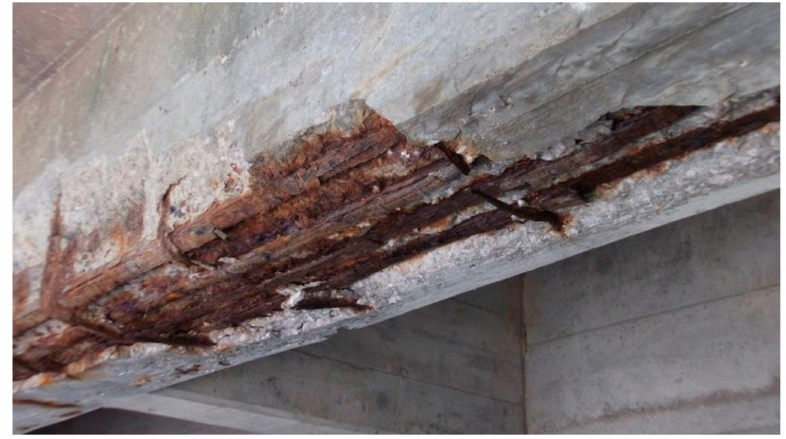
Figure 2. Display of reinforcement corrosion effects in reinforced concrete